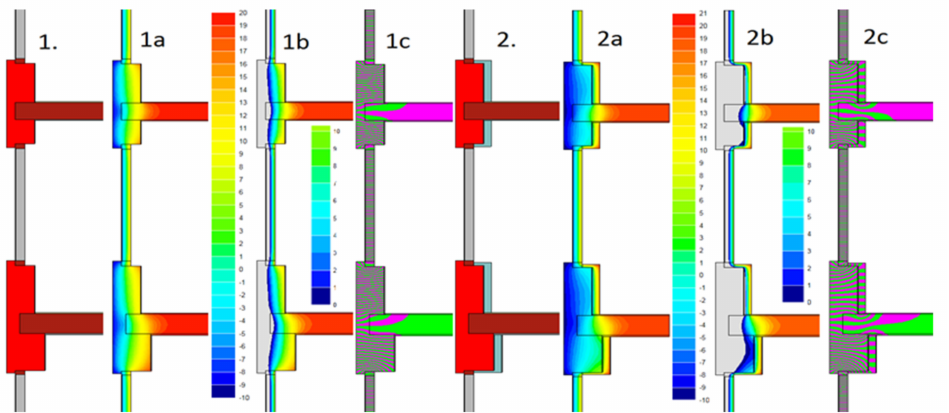
Figure 4. Models of temperature distribution in the external wall in the place of the support of wooden ceiling beams: ( 1 , 2 ) model of the partition in its original state (after thermal insulation from the inside), ( 1a , 2a ) temperature distribution field, ( 1b , 2b ) temperature distribution field limited by an